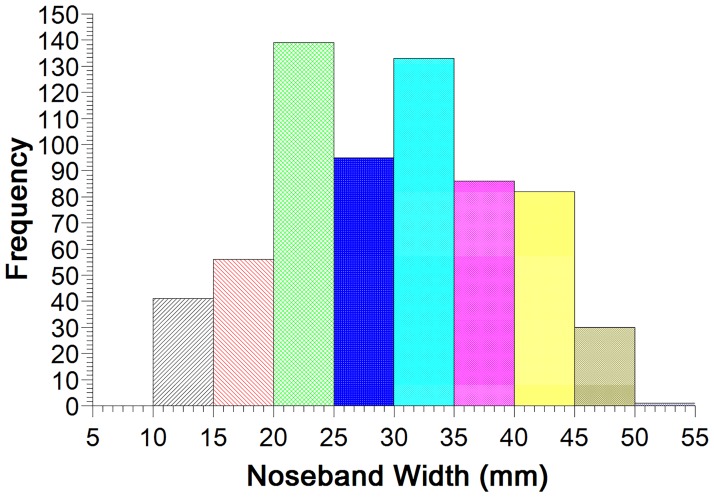
Distribution of noseband widths.